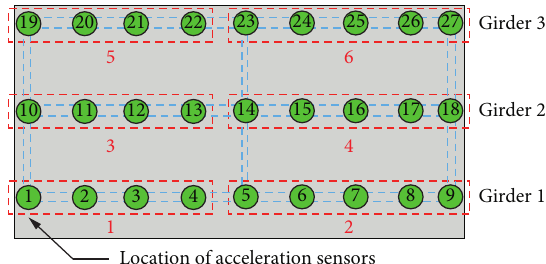
Figure 21: Selection of the updating parameters in Case 2.